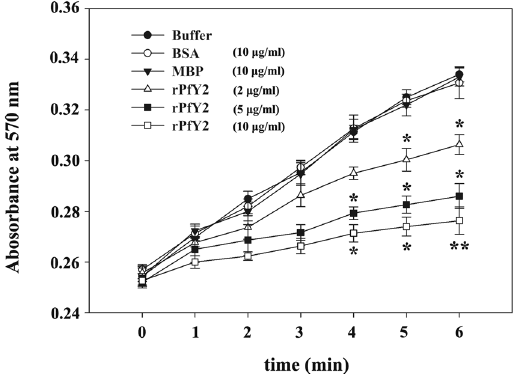
Figure 8. In vitro inhibition of rPfY2 on CaCO 3 crystallization precipitation. CaCO 3 precipitation rate was indicated by the absorbance of crystals at 570 nm. 2 μ g/ml rPfY2 was effective ( p < 0.05) to inhibit the precipitation rate 5 min after reaction compared with the buffer group (negative control group) and this inhibitory activity was dose-dependent. * p < 0.05; ** p <